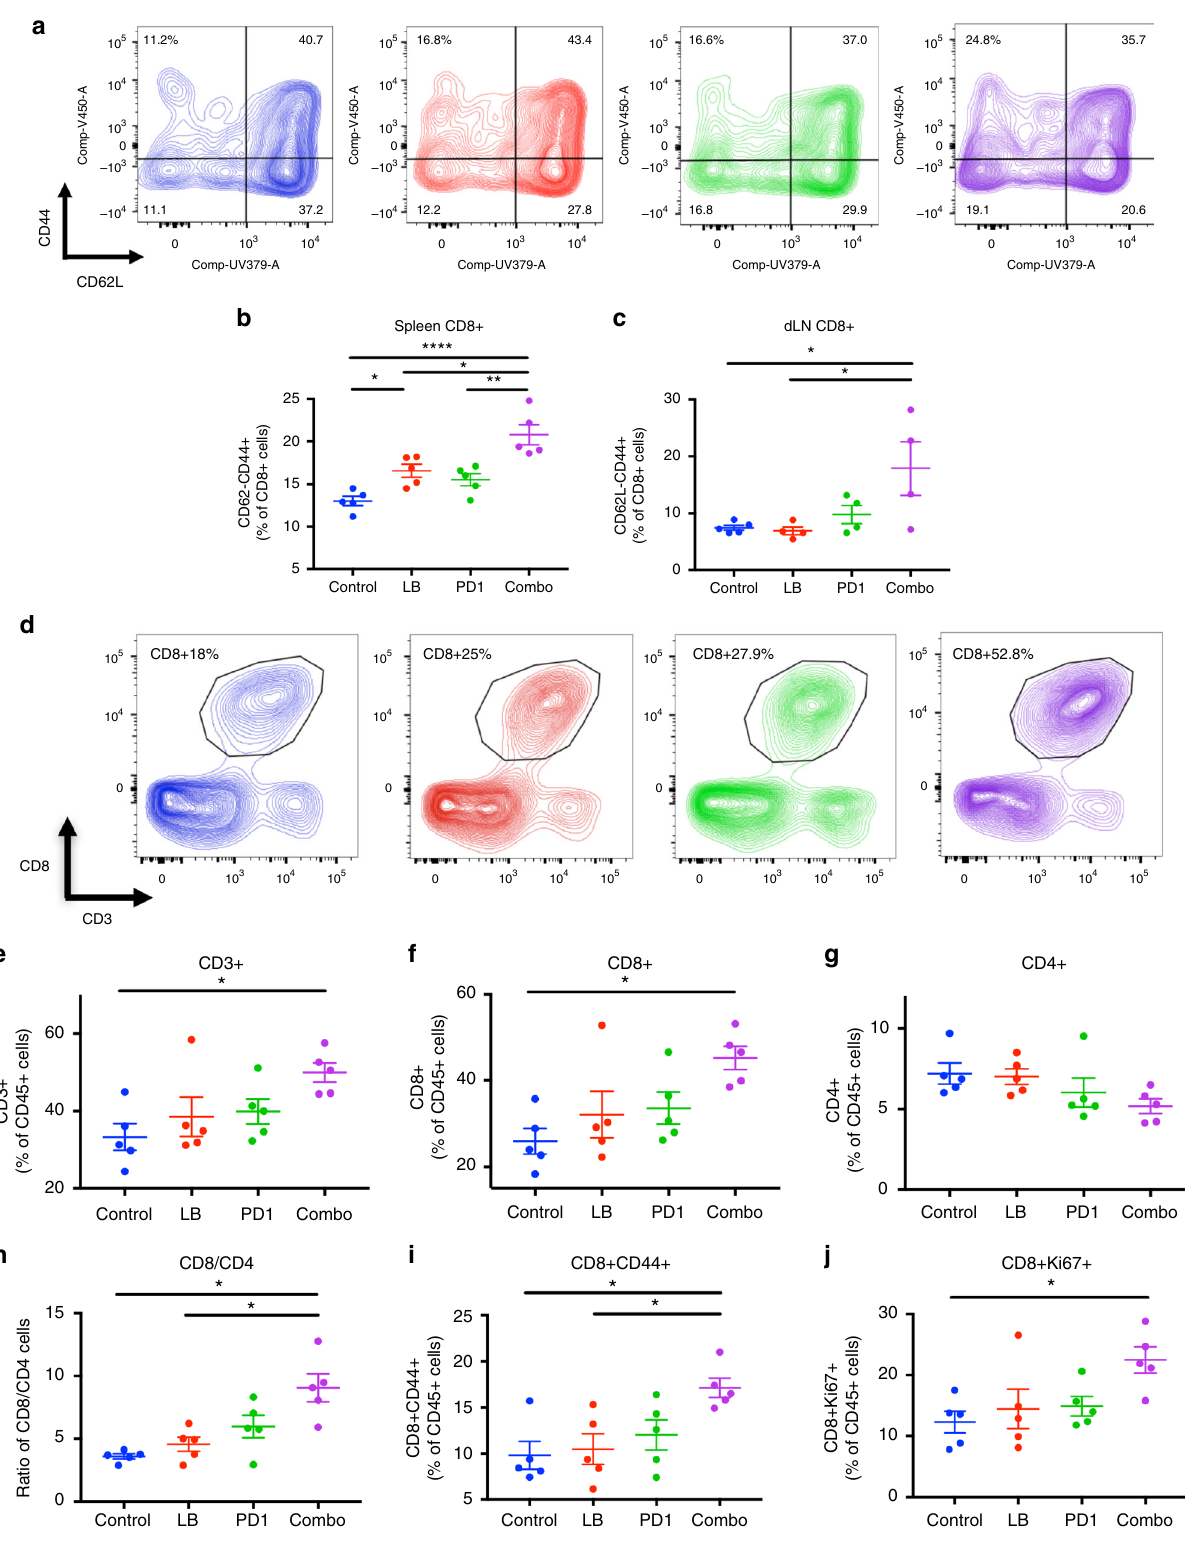
Fig. 3 PP2A inhibition and PD-1 blockade increase CD8 + activation in lymphoid organs and CD8 + in fi ltration in tumors. Balb/c mice in the respective groups were harvested 3 days after initiation of treatment and the spleen, tumor draining lymph nodes (dLN) and tumors were analyzed by fl ow cytometry. a Representative FACS plots of CD44 and CD62L in CD8 + T cells in the spleen. b Quanti fi cation of CD62-CD44 + (of CD8 + T cells) in the spleen and c tumor draining lymph nodes ( n = 4 – 5). d Representative FACS plots of CD8 + CD3 + T cells as percentage of CD45 + cells. e – g Immune in fi ltrate analysis of e CD3 + , f CD8 + , and g CD4 + expressed as percentage of CD45 + cells ( n = 5). h Ratio of CD8 + to CD4 + cells in tumor. i CD8 + CD44 + and j CD8 + Ki67 + expressed as percentage of CD45 + cells in tumor. * P < 0.05, (one-way ANOVA with Tukey ’ s multiple comparison test). Error bars depict SEM. Data represent one of two experiments with fi ve independently analyzed